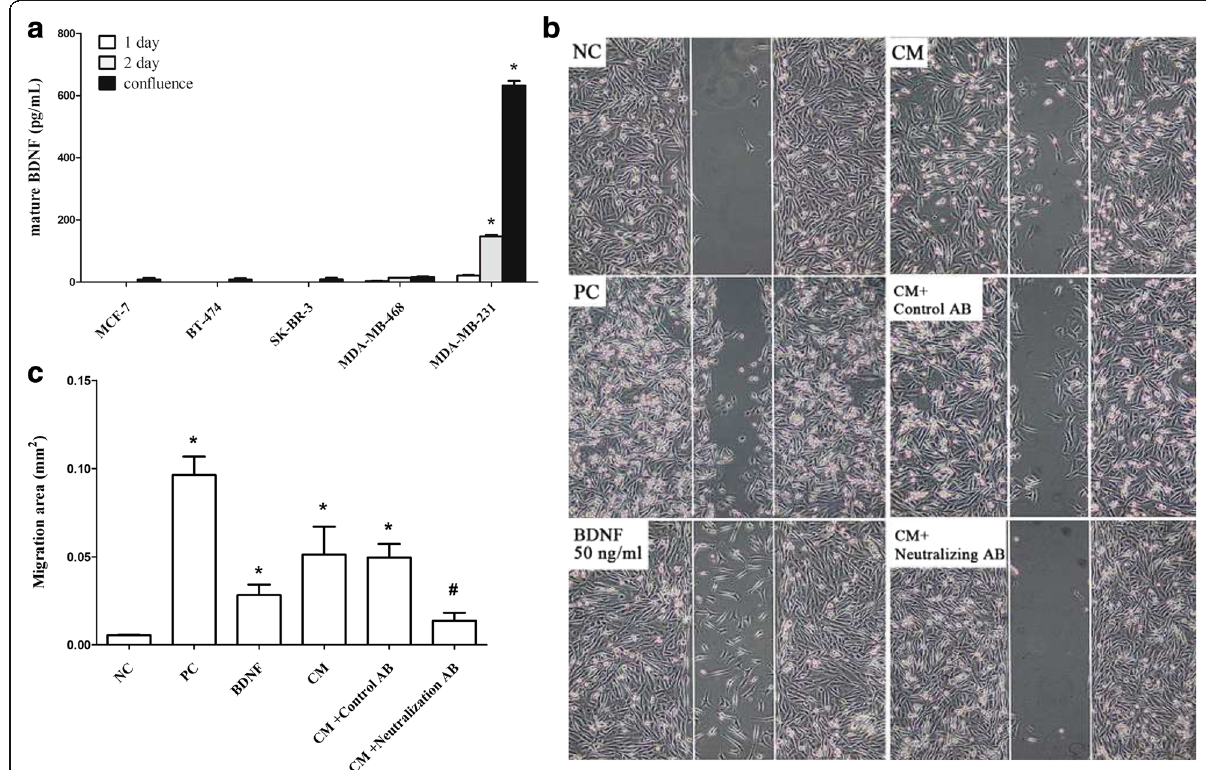
Fig. 2 BDNF levels in various culture media and the protein ’ s effect on cell migration using the MDA-MB-231 line. Different breast cancer cell lines, such as MCF-7, BT-474, SK-BR-3, MDA-MB-468 and MDA-MB-231 (4 × 10 5 /well), were cultured for 1 day and this was followed by replacement by low serum medium at 24 h (white bar), 48 h (grey bar) and confluence (black bar). Next the culture media were collected to allow the BDNF level in each medium ( a ) to be measured by ELISA as described in Methods. A cell migration assay ( b ) using a cell culture insert, as described in Methods, was carried out in the presence of serum free medium (the negative control, NC), 10% FBS medium (positive control, PC) BDNF (50 ng/mL), or 2-day- cultured medium (conditioned) medium (CM) using MDA-MB-231 cells without or with pretreatment with a neutralization antibody against BDNF or non-specific antibodies. The percentage of migratory cells ( c ) was measured by comparing the treated group with the vehicle group. Data are expressed as mean + SEM. *, p < 0.05 compared to fresh prepared medium (day 0) or serum free (negative control), one way ANOVA. #, p < 0.05 compared to CM-treated group (n = three or four independent experiments in each group) by Mann-Whitney U